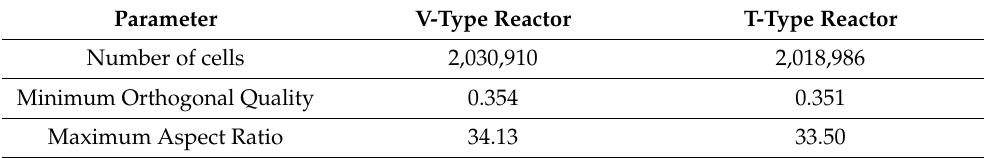
Table 4. Mesh parameters used for different reactor types.